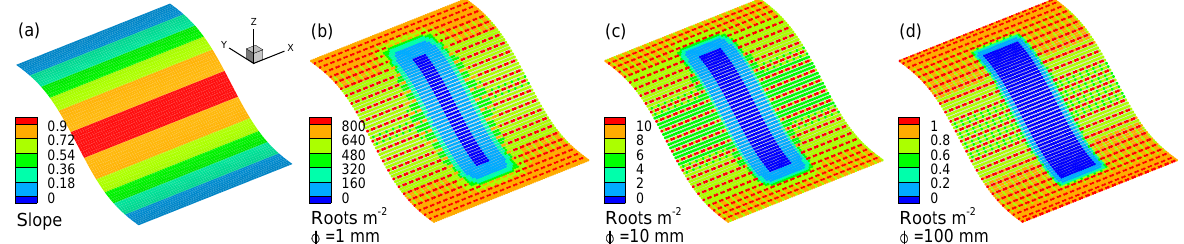
Figure 5. Tree-covered sigmoid slope, 70m × 70m, with a 20m × 50m clearing in its center. (a) Slope (unitless) with cell discretization (1m). Density of roots crossing a vertical plane in units of roots per square meter for roots of diameter (b) 1mm, (c) 10mm, and (d)